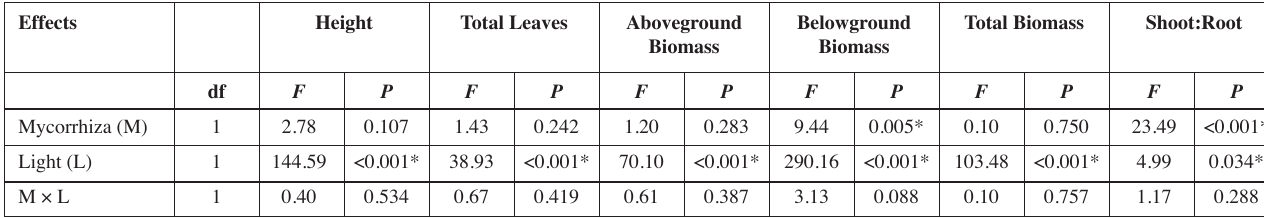
Tab. 1: Summary of ANOVA results of the effects of mycorrhizal fungi and light availability on vegetative plant traits.